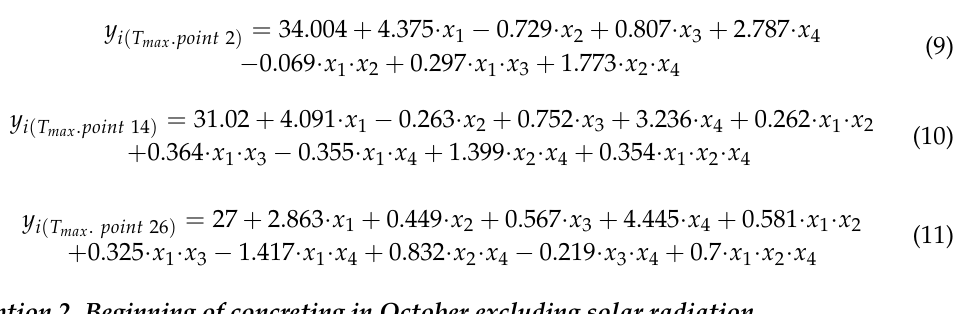
Figure 7. Location of fixed points for the values of the set responses across the cross section of the dam. Regression equations were derived from the calculations to determine the values of the response functions, some of which are presented below (9–20): Option 1. Beginning of concreting in May excluding solar